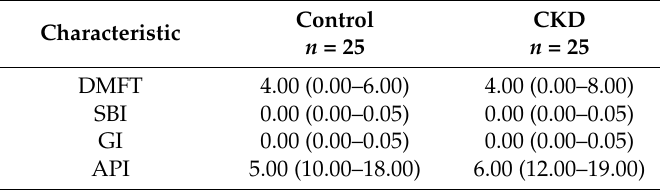
Table 2. Dental examination of children with chronic kidney disease (CKD) and healthy controls.